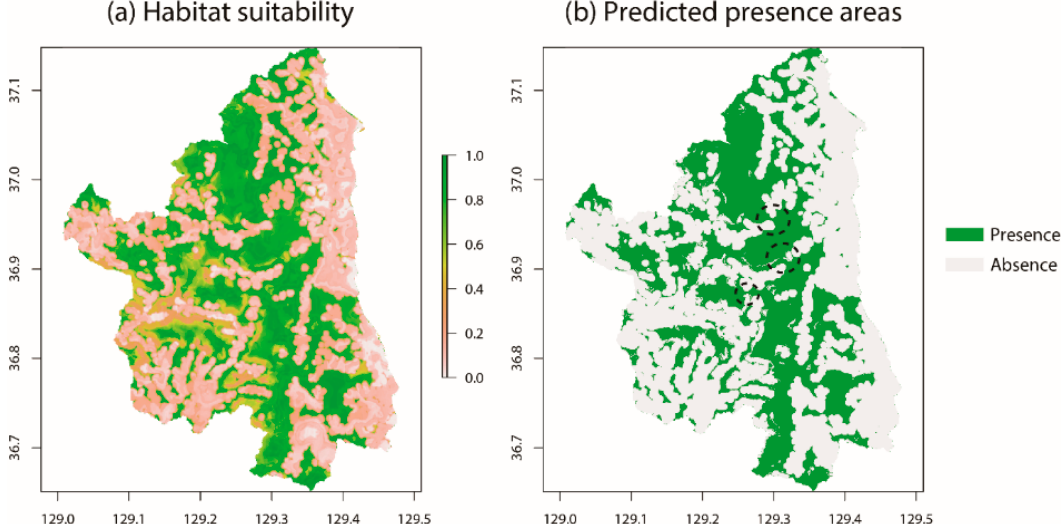
Figure 5. Habitat suitability ( a ) and predicted presence-absence areas ( b ) within the study sites. ( a ) Areas with high suitability are represented in green, whereas low suitability areas are represented in pink. ( b ) Predicted presence areas are represented in green, whereas absence areas are represented in light gray. The dotted circles indicate areas where the connectivity between fragmented areas is low.